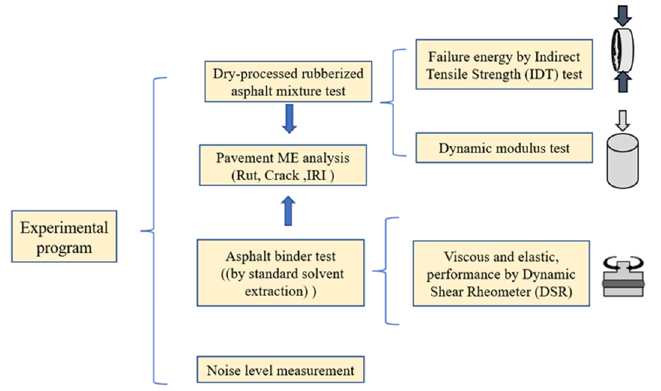
Figure 4. Technical flowchart used in the research.